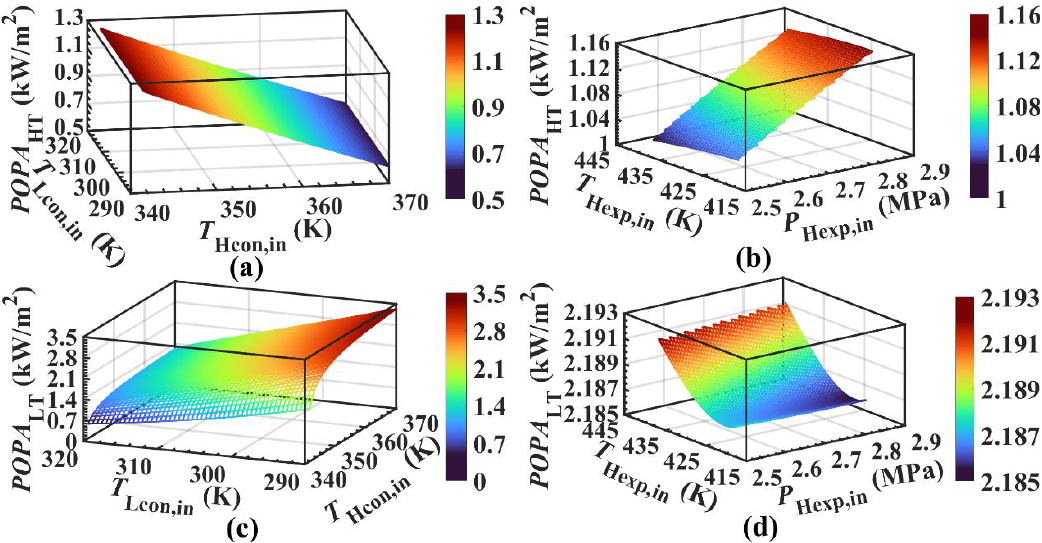
Figure 12. Influence characteristics of key variables on POPA of HT cycle and LT cycle. (a) POPA effect characteristics of the condenser inlet temperature in different loops on the HT cycle. (b) Effect characteristics of POPA in the HT cycle. (c) POPA effect characteristics on the LT cycle. (d) Effect characteristics on the HT cycle.